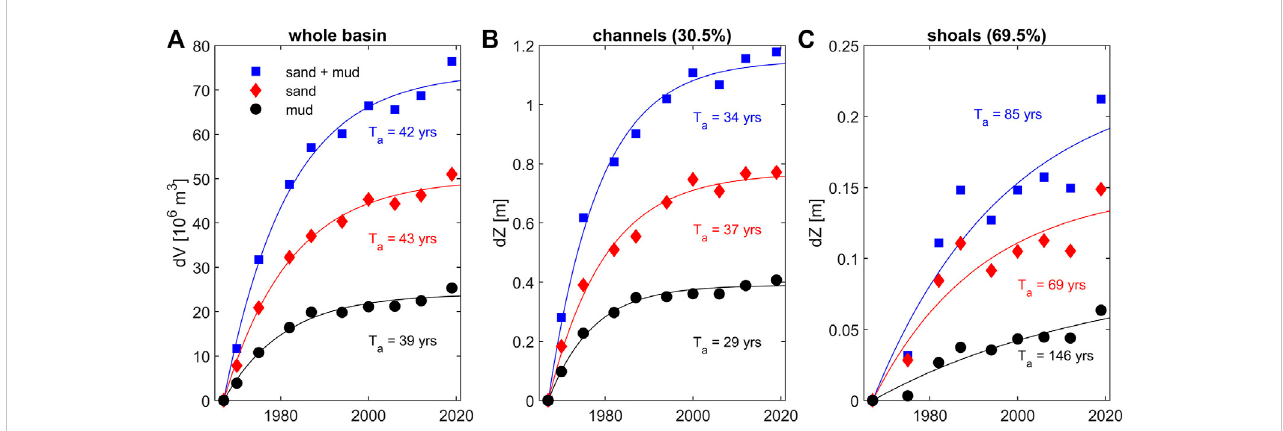
FIGURE 9 Total volume changes (a, in 10 6 m 3 ) of sand and mud in the Zoutkamperlaag basin in fl uenced by closure of the Lauwers Sea (see Figure 2 for location), and accretion rates (in m) in the tidal channels and on the shoals. The volume changes have been converted to accretion rates according to their areal size (46.010 6 m 2 for thechannels and104.610 6 m 2 fortheshoals).The adaptiontimescale Taiscomputedusing Eq.1 (withcolouringdenotingthesedimenttype Ta is computed for). The channel and shoal percentage of panel (B) and (C) provide the spatial coverage relative to the total (A)